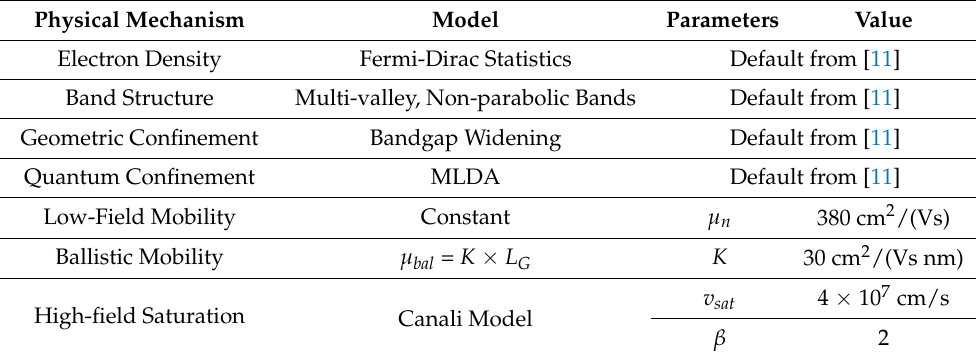
Table 3. Main model parameters of the